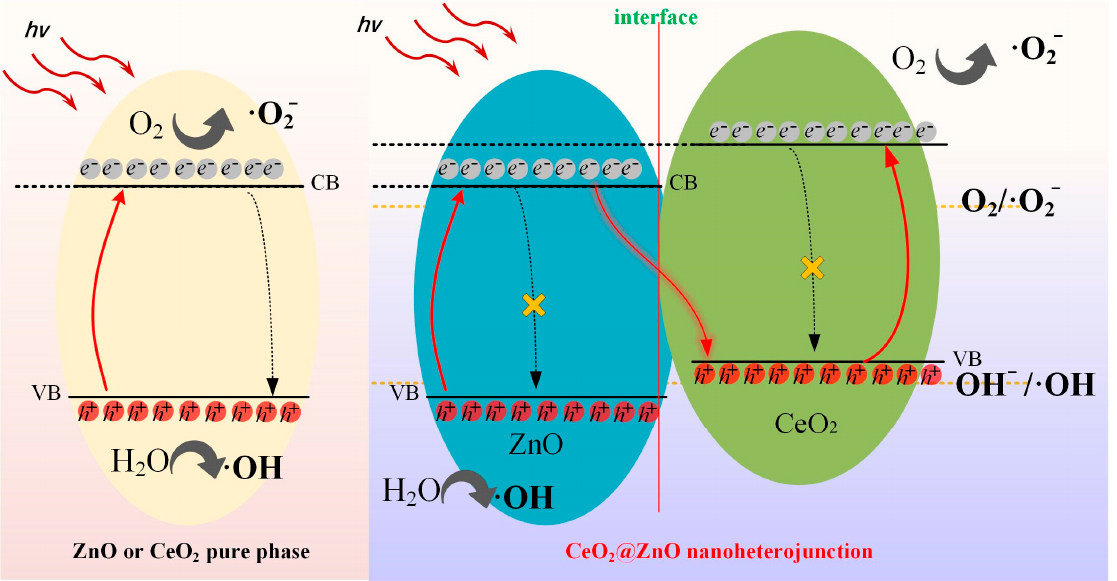
Figure 10. Separation mechanisms of photogenerated electron–hole pairs of the pure phase materi- als and the CeO 2 @ZnO nanoheterojunction.